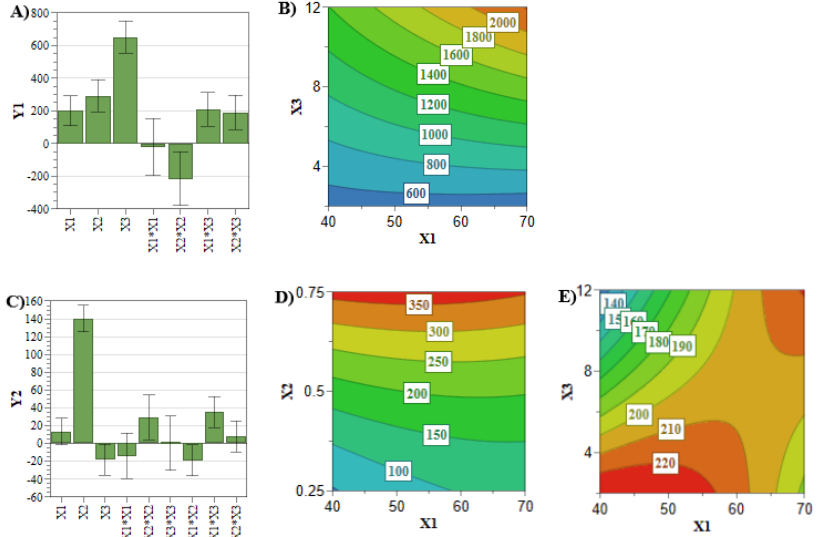
Figure 3. Coefficient plot for SIM ( A ) and DOX ( C ) entrapped concentration. Response contour plot for SIM entrapped concentration ( B ) and DOX entrapped concentration ( D , E ). X 1 : PL concentration (mM); X 2 : DOX concentration (mM); X 3 : SIM concentration (mM); Y 1 : SIM entrapped concentration (µg/mL); Y 2 : DOX entrapped concentration (µg/mL).